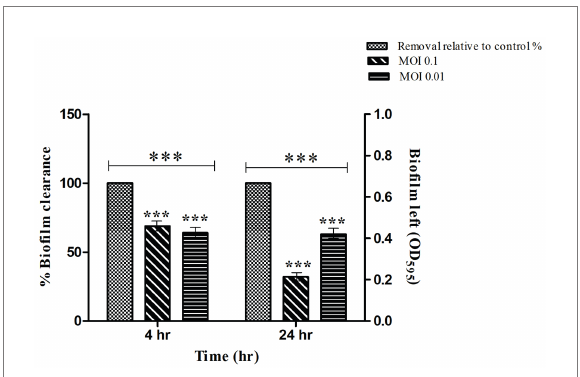
FIGURE 5 Quantification of Salmonella biofilm in Microtiter Plate. A 24 h biofilm of S. typhi formed in 96-well plates was treated with phage STWB21 at m.o.i 0.1 and 0.01 concentrations both at 4 h and 24 h time points. All the values were tabulated as mean ± SD and a significant difference between variations was denoted by asterisks (*** p < 0.001) using two-way ANOVA.